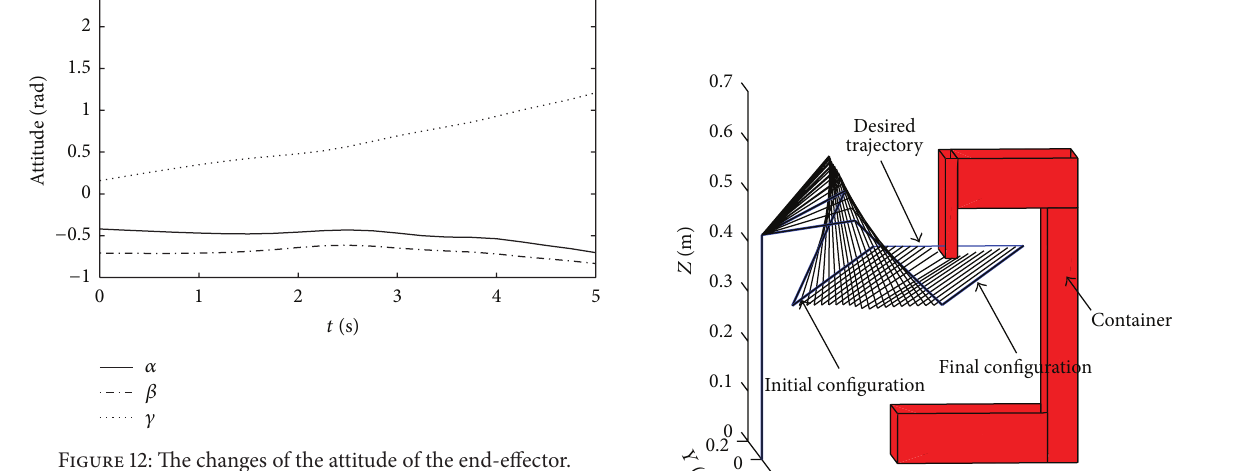
Figure 12: The changes of the attitude of the end-effector.